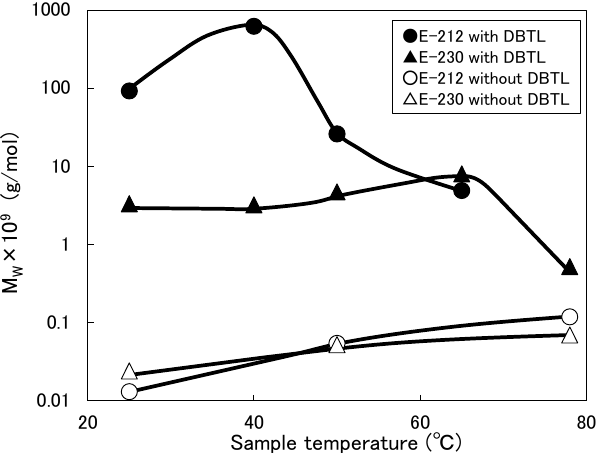
Figure 7. Relationship between sample temperature and weight-average molecular weight (M W ) (surfactant: E-212 and E-230 with or without DBTL).